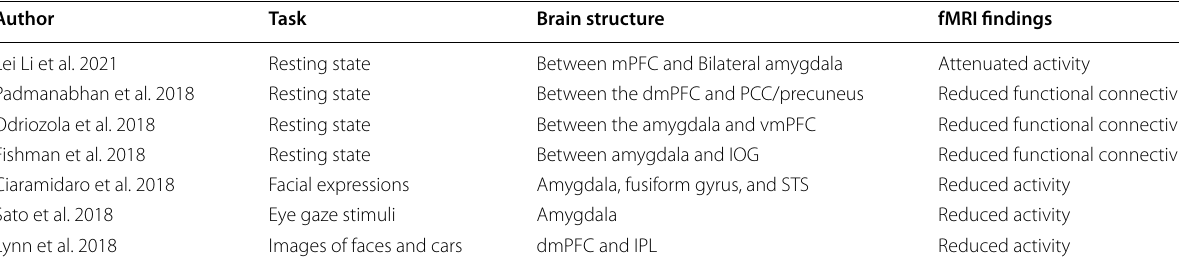
Table 2 Summary of fMRI changes in ASD